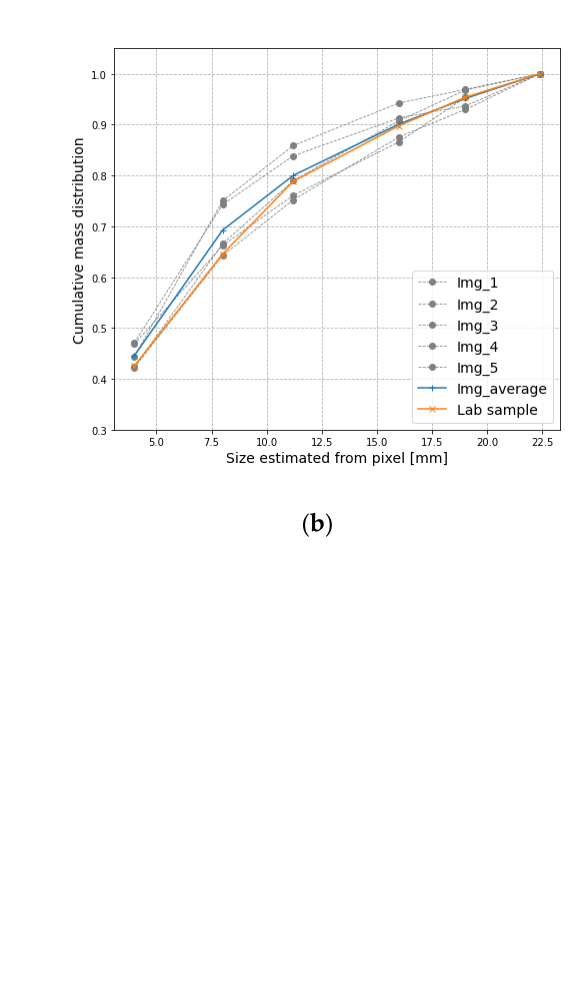
100 Table 5. The results of lab sampling. Columns